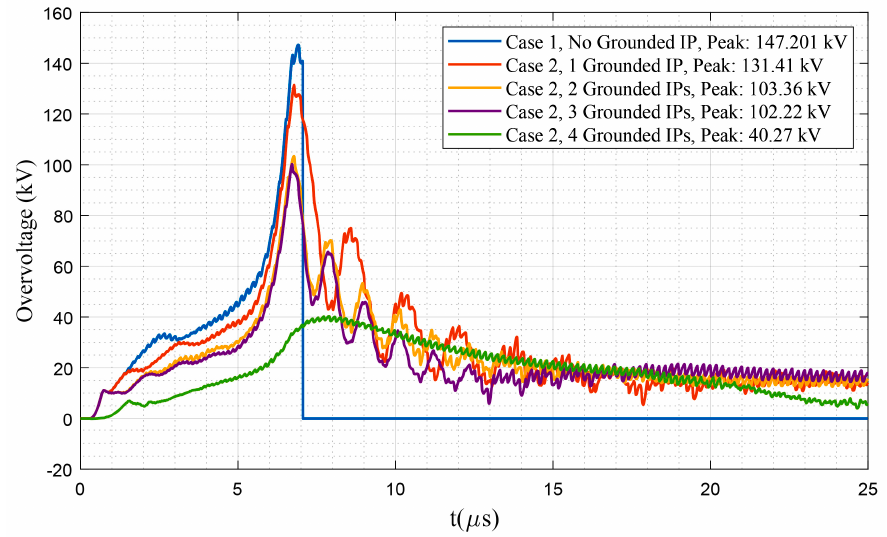
Figure 3. Comparison among the overvoltage stress at terminal c of the transformer mounted at pole #36, network with dry poles under a lightning strike on pole #35, Case 2. #36, network with dry poles under a lightning strike on pole #35, Case